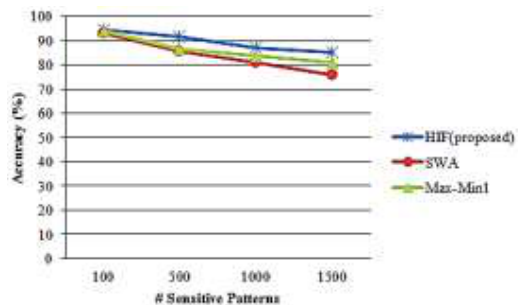
Figure 6. Accuracy of dataset produced by HIF, Max- Min1 and